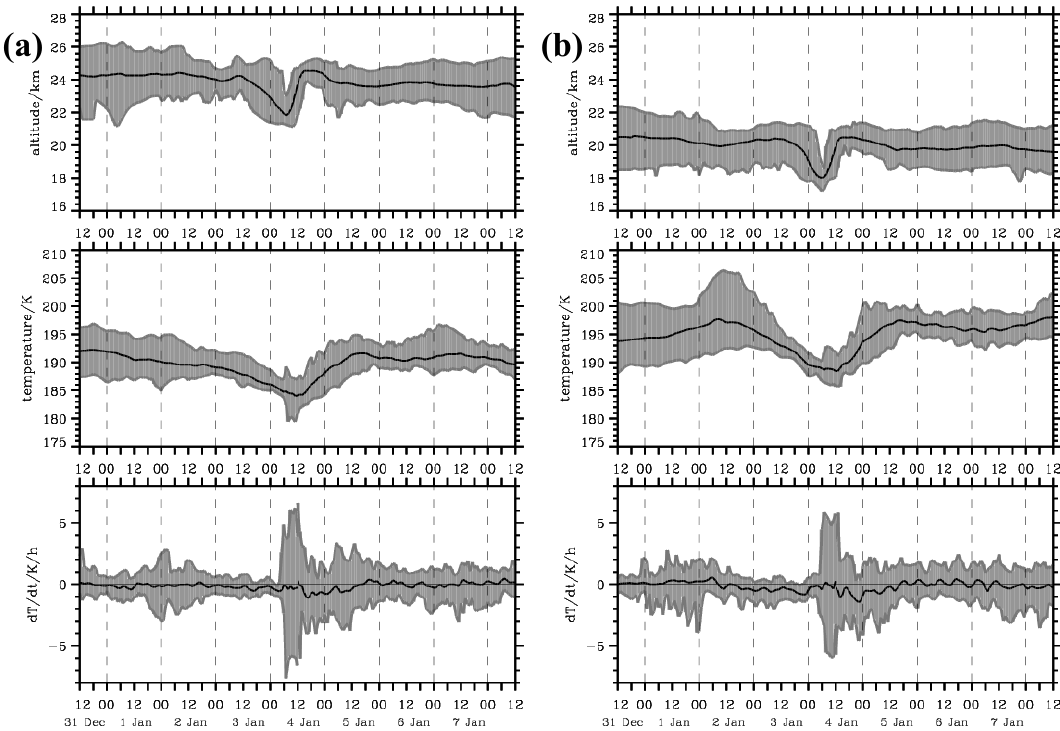
Fig. 19. Stratospheric gravity waves: time series of selected quantities of forward and backward trajectories launched at 20hPa (a) and 40hPa (b) on a 1 × 1 ◦ latitude/longitude grid between 68 to 75 ◦ N and 30 to 20 ◦ W on 4 January 2010 12:00UTC. Maximum and minimum values of the ensemble of all trajectories enclose the gray-shaded area of parcels altitude (top row), absolute temperature (middle row), and heating and cooling rate (bottom row. The thick black lines denote the mean value of the respective quantities for the trajectory ensemble.